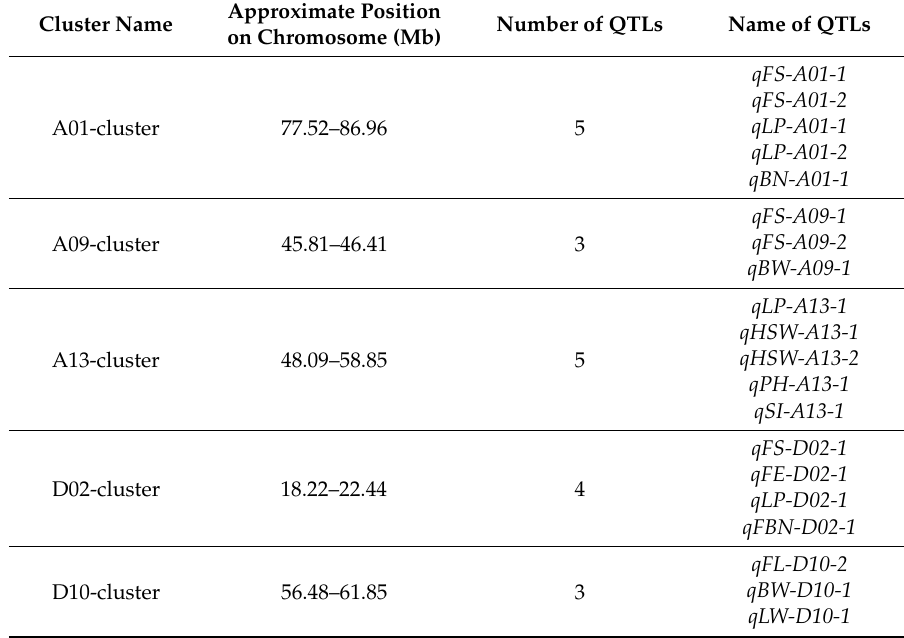
Table 4. Distribution of quantitative trait loci (QTL) clusters on the chromosomes for fiber quality and yield